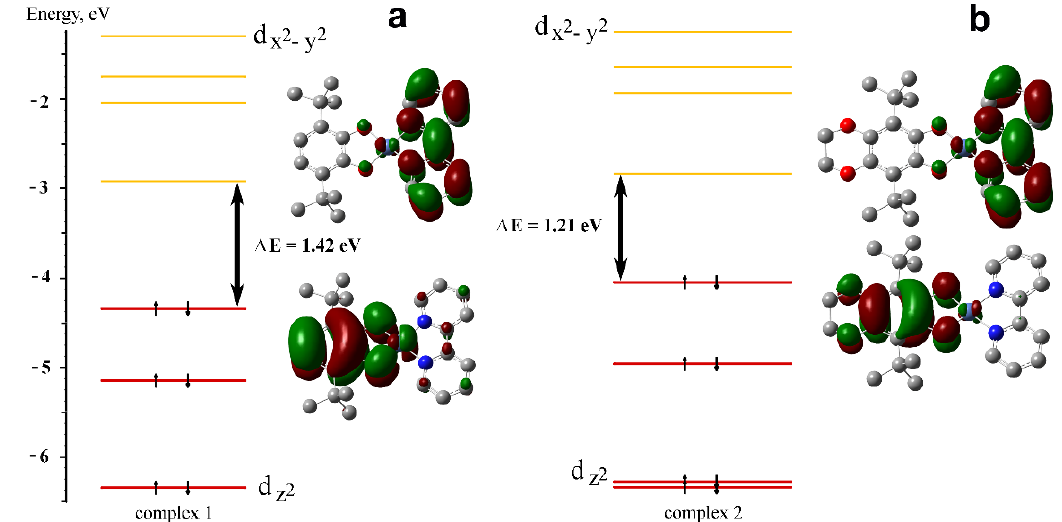
Figure 7. Frontier Kohn–Sham orbital diagram for complexes 1 ( a ) and 2 ( b ) according to DFT calculations at the B3LYP/Def2TZVP level of theory. Isovalue = 0.03 a.u. The H atoms are omitted for clarity.